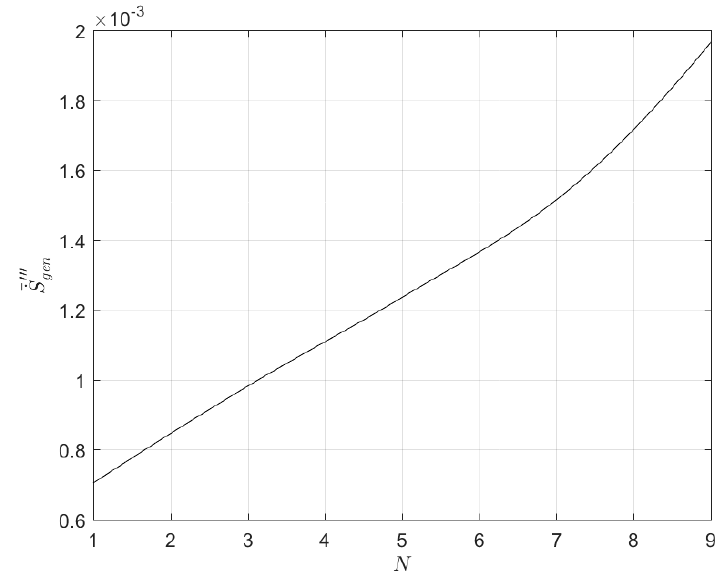
Figure 6. Generated entropy vs. the lamp number for N r = 10 and A R = 1/2.